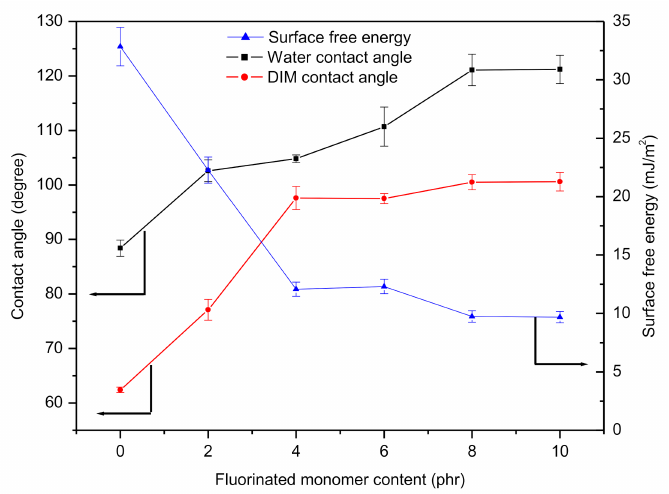
Figure 3. Contact angle ( ◦ ) of the coating and their respective surface free energy (mJ/m 2 ) at different fluorinated monomer content (phr).